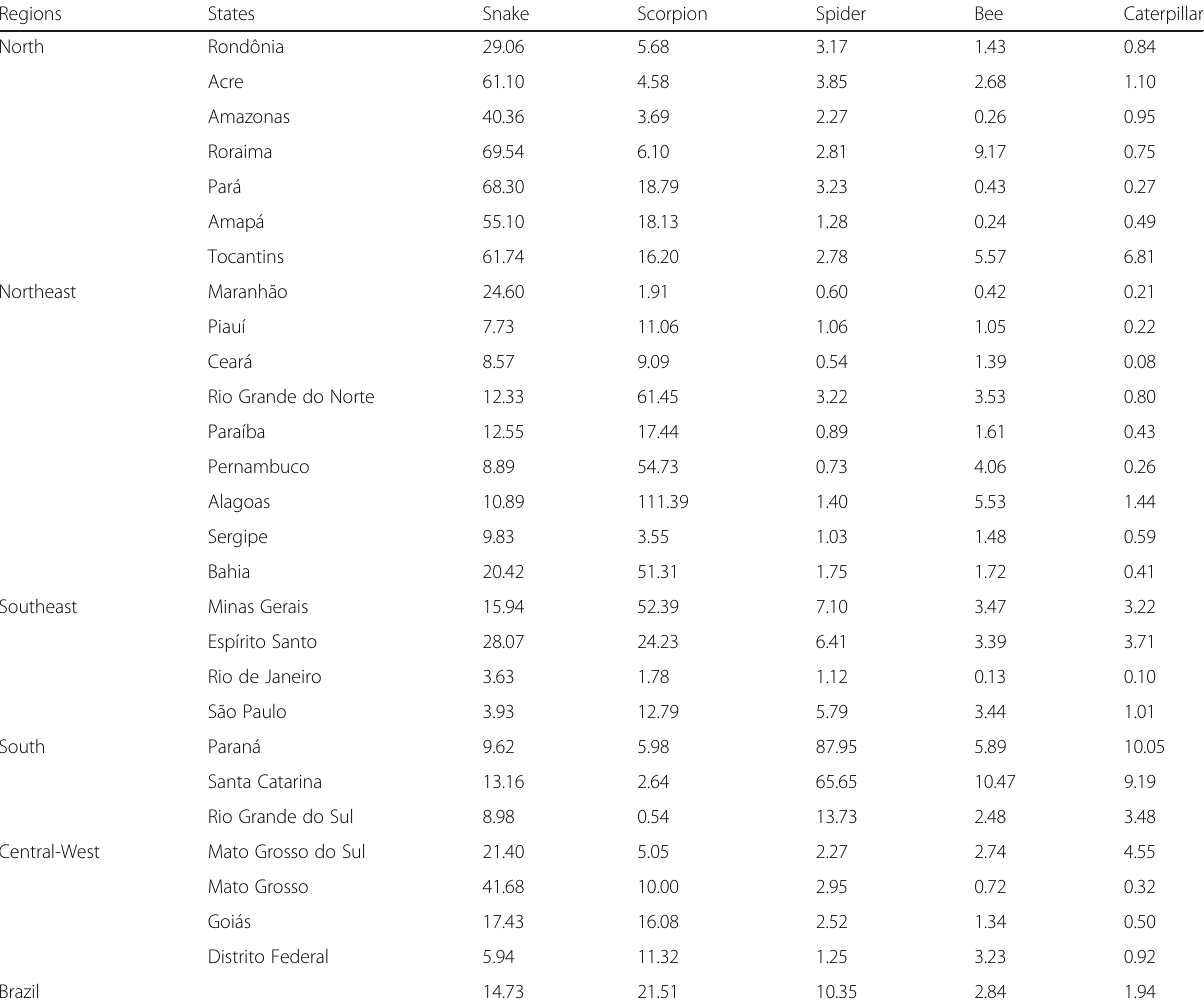
Table 6 Incidence of envenomations (per 100,000 population) according to the states and zoological groups, 2001 – 2012 (except for caterpillar, 2007 – 2012)